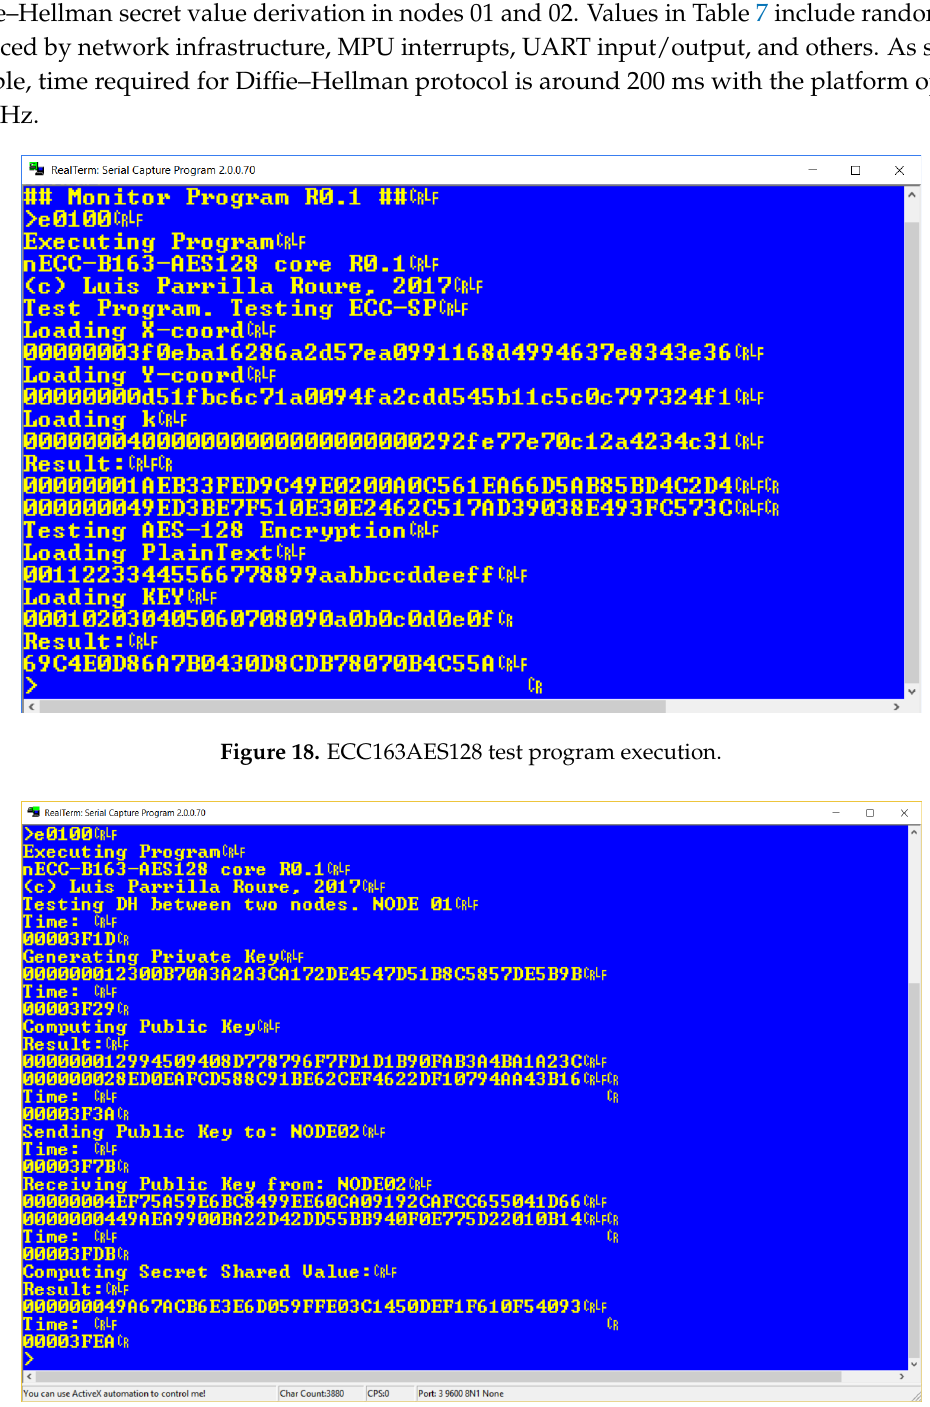
Figure 19. ECC163AES128 Diffie–Helmann between two